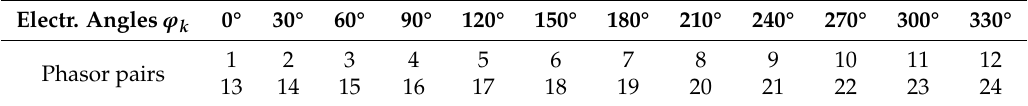
Table 4. Electrical angles of the EMF star phasors for N = 24, p = 2 and m = 3. Electr. Angles ϕ k 0°